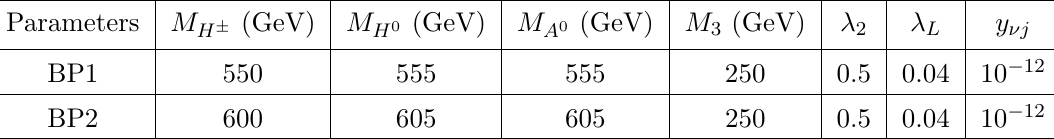
(cid:17) (cid:7) for Type III 3 3